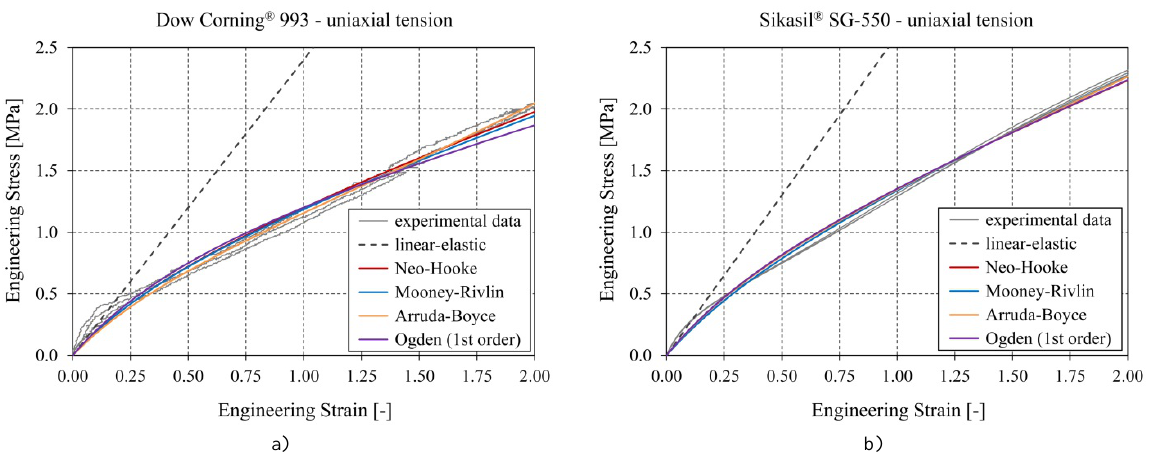
Fig. 5 Engineering stress vs. engineering strain results from the uniaxial tensile tests compared to results obtained with hyperelastic material laws for a) Dow Corning ® 993 and b) Sikasil ® SG-550.